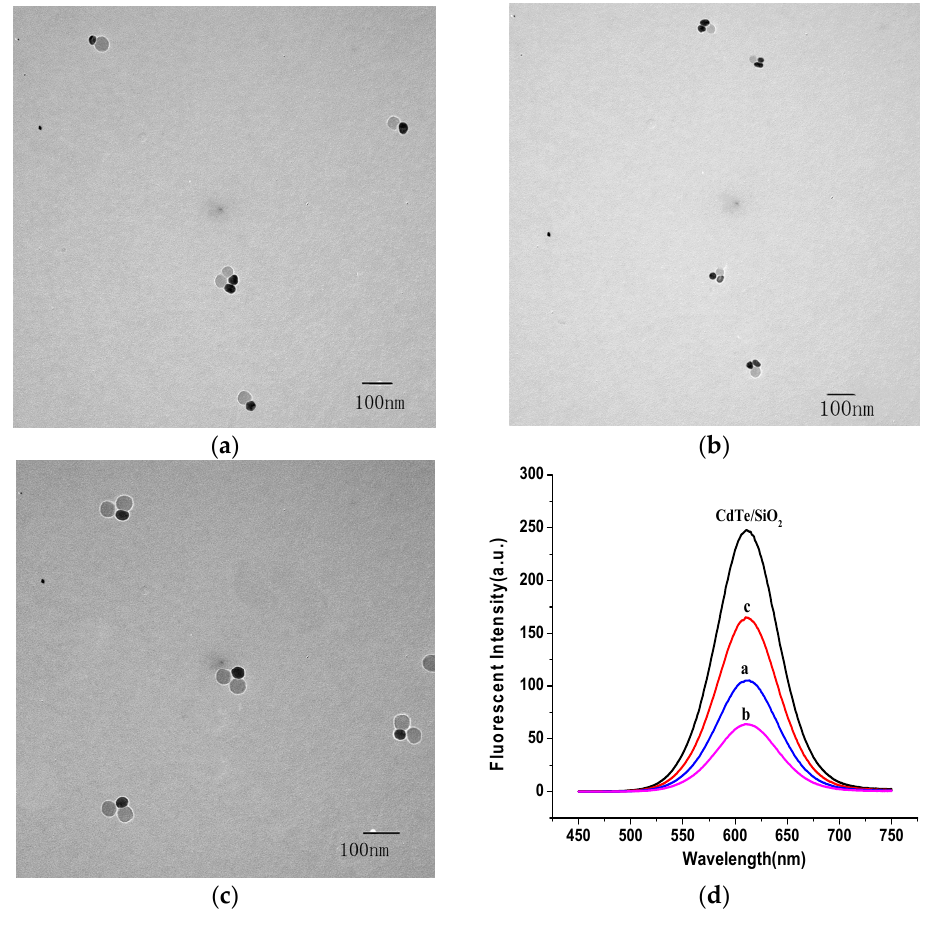
Figure 6. Different nanostructure of fluorescent DNA probes by DNA hairpin template. ( a ) 1:1; ( b ) 1:2; ( c ) 2:1; and ( d ) corresponding fluorescent emission spectra.